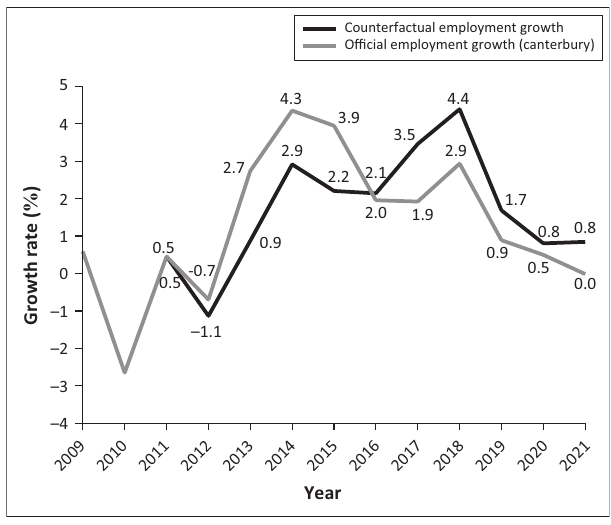
FIGURE 5: Employment growth,